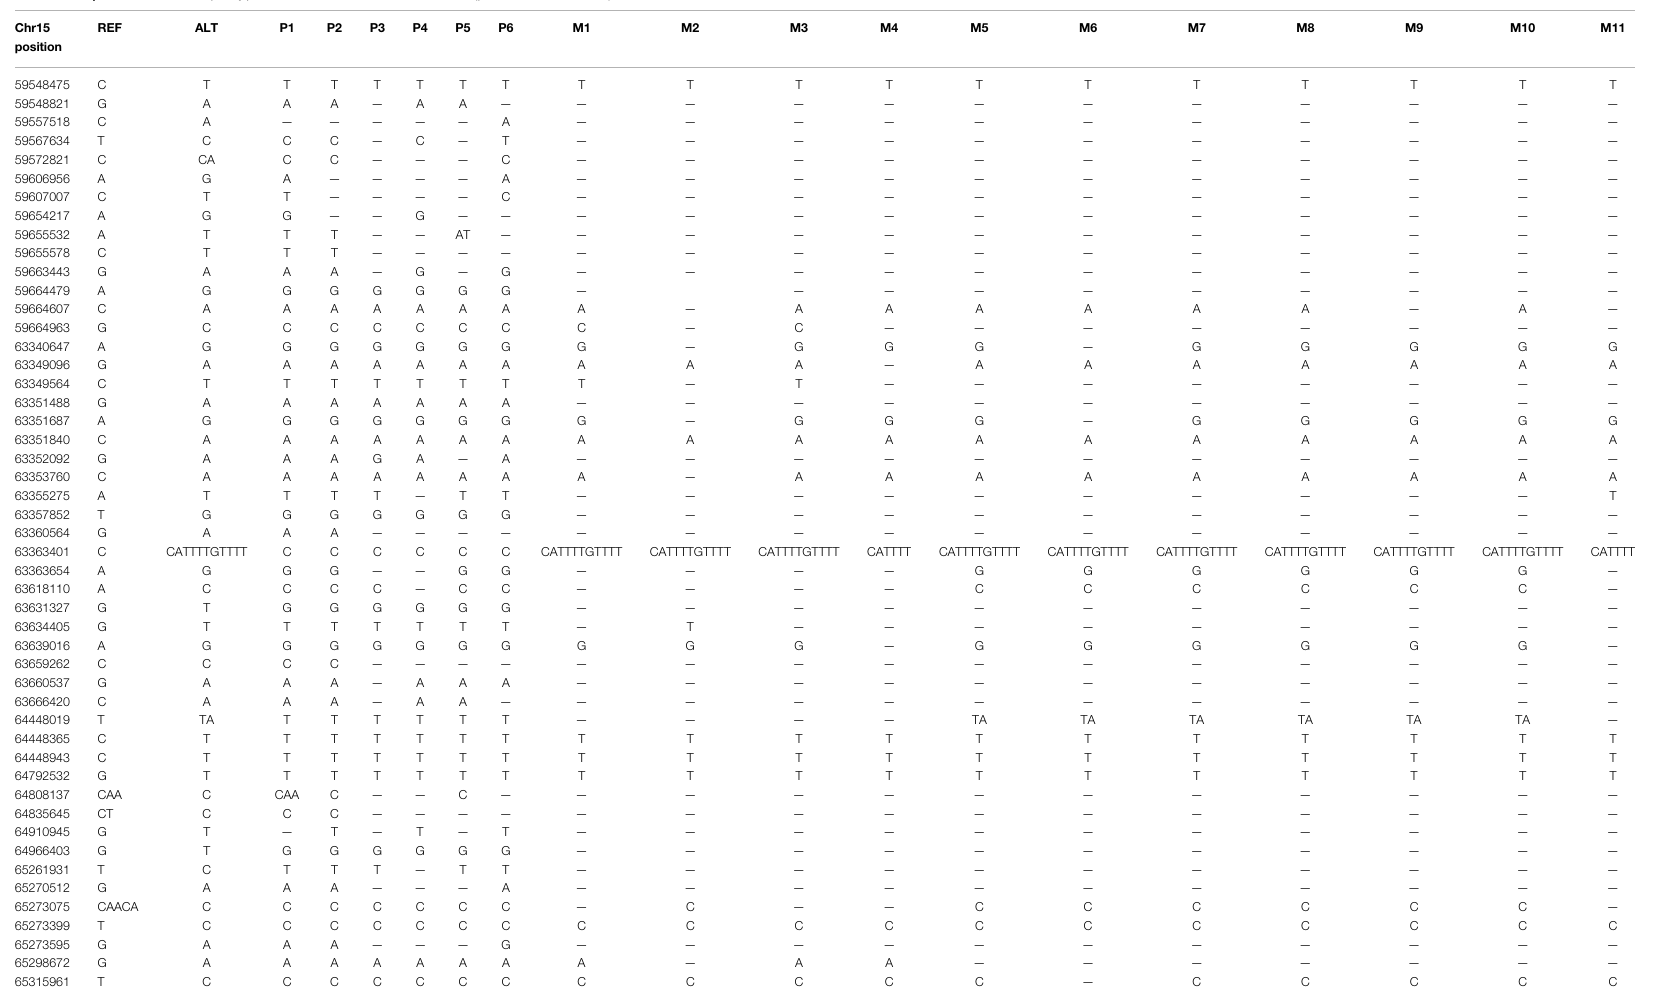
TABLE 2 | The shared haplotypes at the PPIB mutation site (position 6448943). Chr15